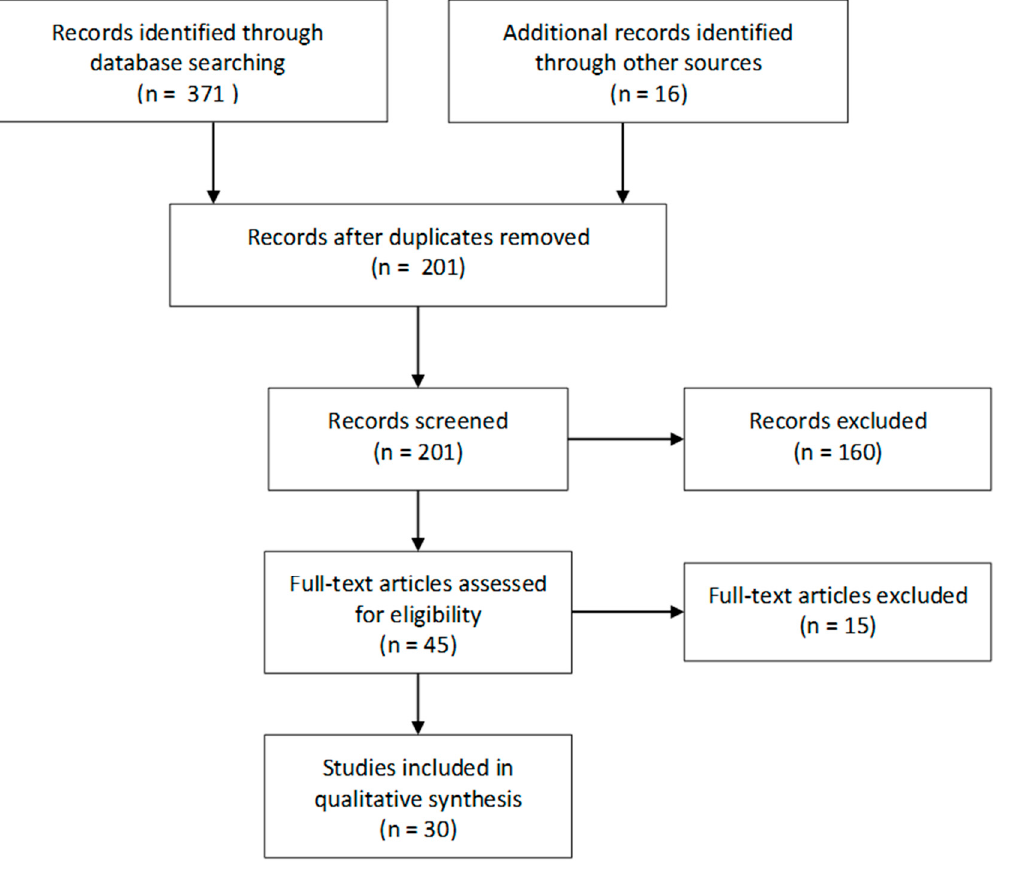
Figure 1. PRISMA flow chart.